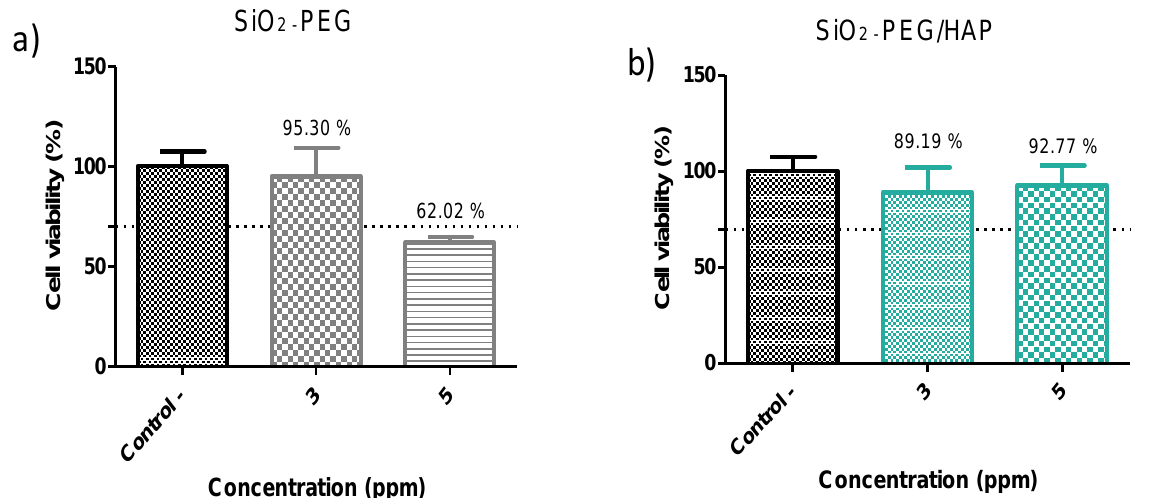
Figure 10. Percentage of cell viability of ( a ) SiO 2 -PEG and ( b ) SiO2-PEG/HAp samples, cultured in 3T3 cells during 24 h of exposure, evaluated at 3 and 5 ppm of sample concentration.